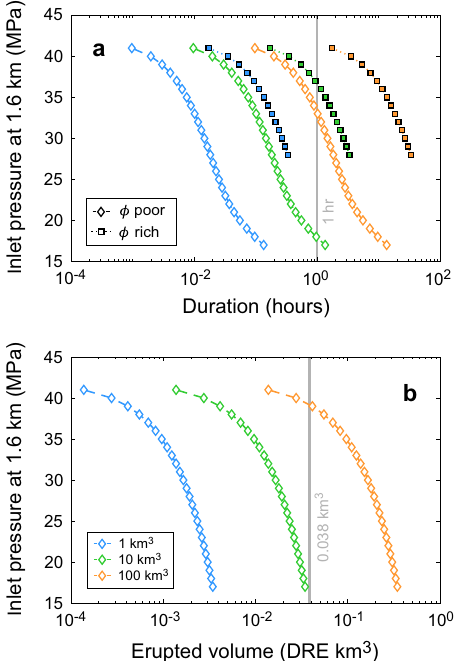
Fig. 8 Variation in eruption duration and erupted volume with inlet pressure for different chamber volumes for Plinian phase TLL2 of the MTL eruption. Results for the crystal-poor endmember are shown by the open diamonds, and results for the crystal-rich endmember are shown by the fi lled squares for the variation in ( a ) eruption duration and ( b ) erupted volume with inlet pressure. The duration and erupted volume of Plinian phase TLL2 calculated by Pérez et al. 3 (phase II) are shown as grey bars. In ( b ) we plot only the results of the crystal-poor simulations, as those of the crystal-rich simulations are coincident, but instead the fi nal crystal-rich simulation corresponds to an inlet pressure of 28 MPa. The crystal-poor and crystal-rich simulations are coincident as a result of Eq. (4), where the erupted volume depends on the properties of the magma chamber and δ p ch , which are fi xed for a given